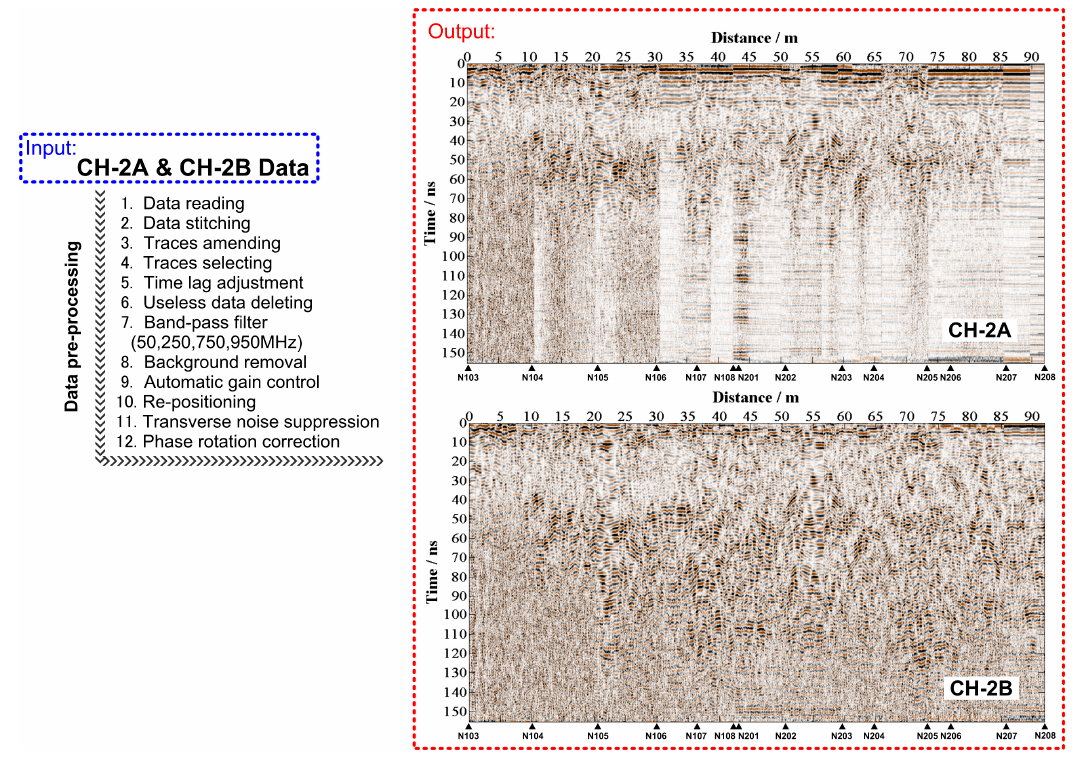
Figure 3. A pipeline chart of CH-2 LPR data processing. N103-N209 denote the positions.